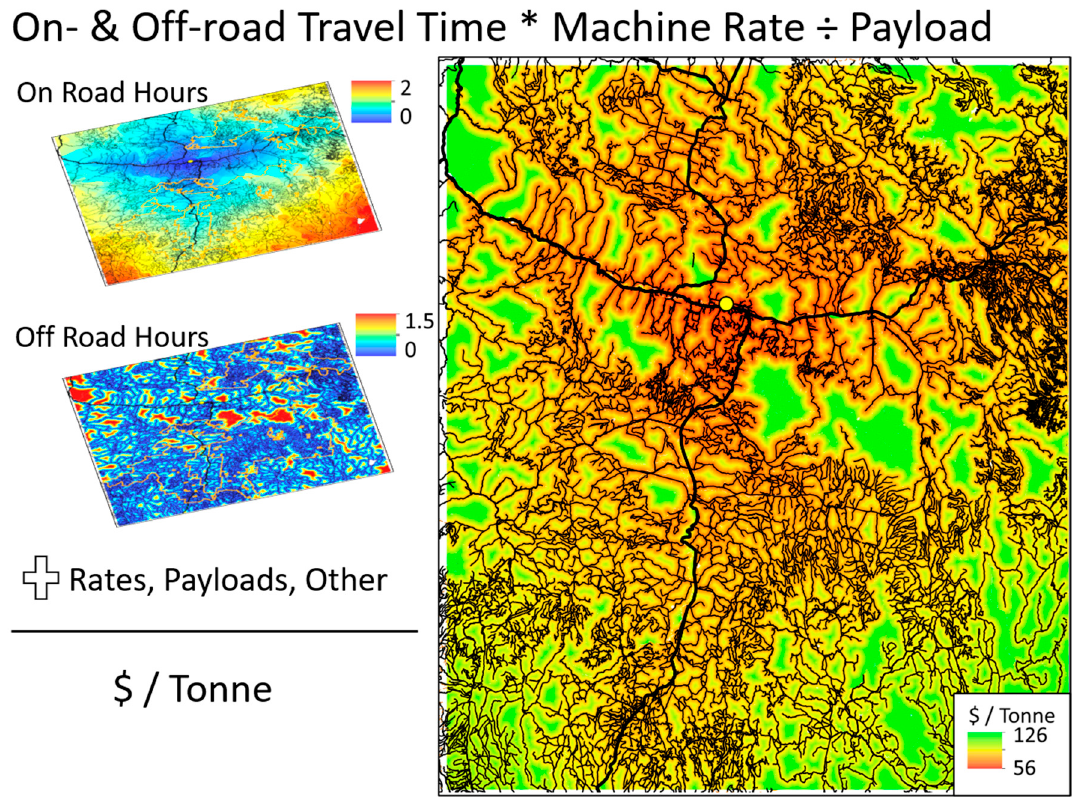
Figure 9. Geospatial processes and outputs from the delivered optimum potential total cost (OPTC) model [24]. Raster cell values depicting travel times and delivered costs spatially quantify the potential time and corresponding cost using machine rates and payloads (Table 5) to move woody biomass from a given location on the landscape to the Malheur Lumber Company (yellow point within each graphic). Linear road network (black lines) is displayed for reference in the various graphics.